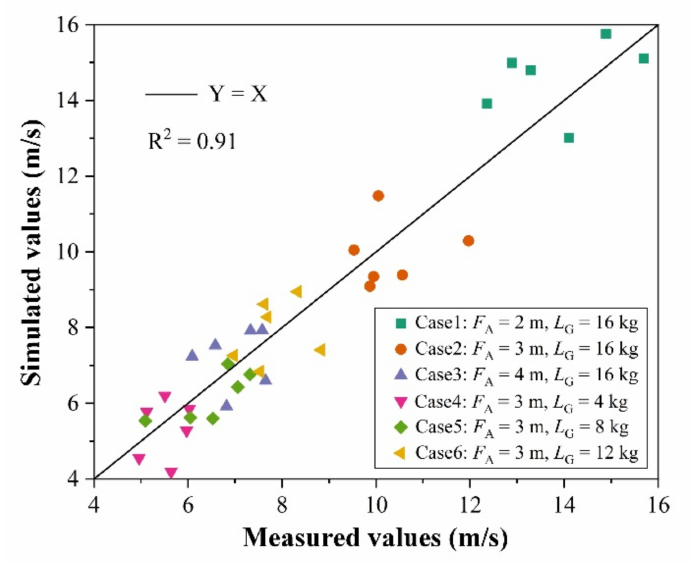
Figure 14. Comparison between the measured and simulated values of V VD in marked